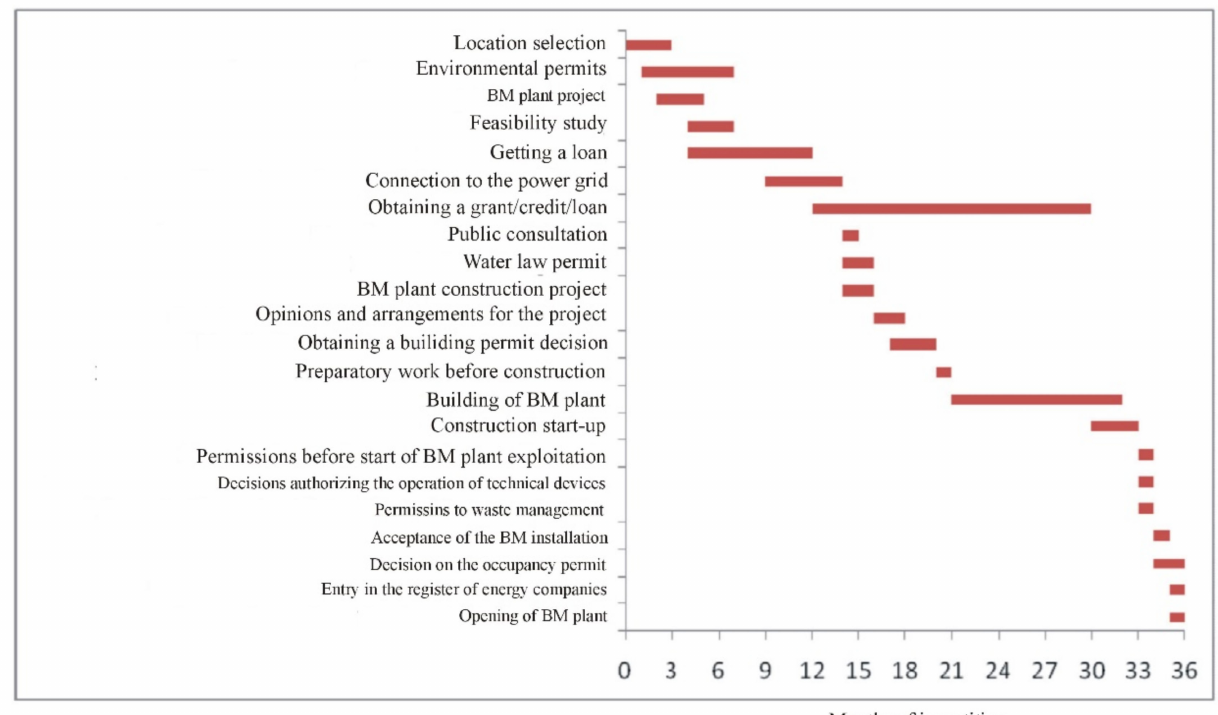
Figure 16. Schedule for the implementation of BM investments in Poland in the form of a Gantt